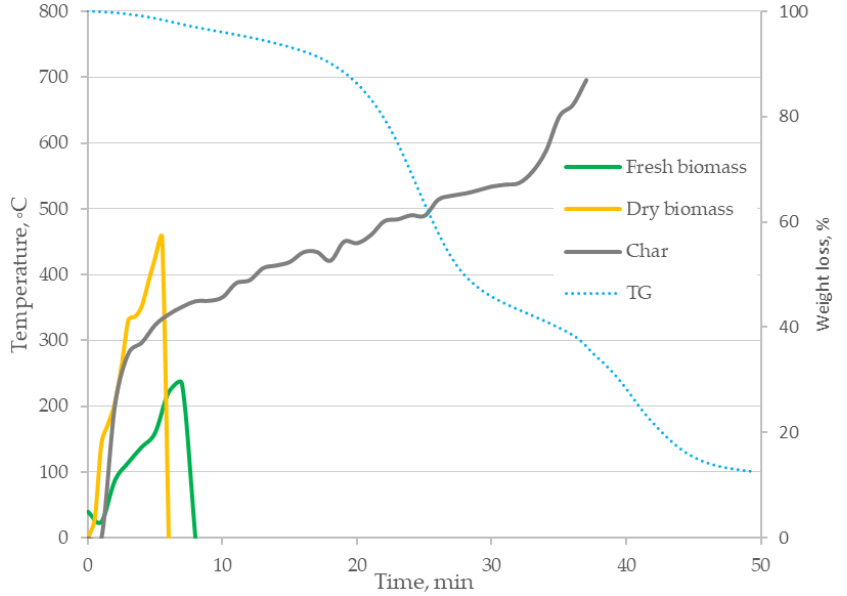
Figure 12. Change in the temperature of fresh biomass, dry biomass and char — sample 75K25J.